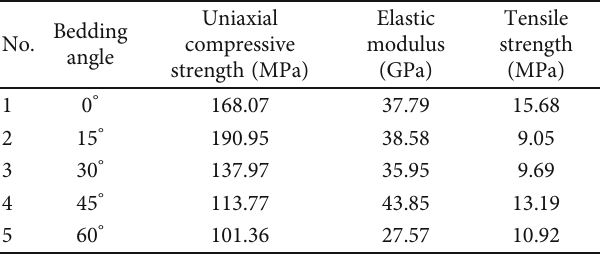
stress. Figure 4 is the schematic diagram of the hydraulic frac- turing experimental system.